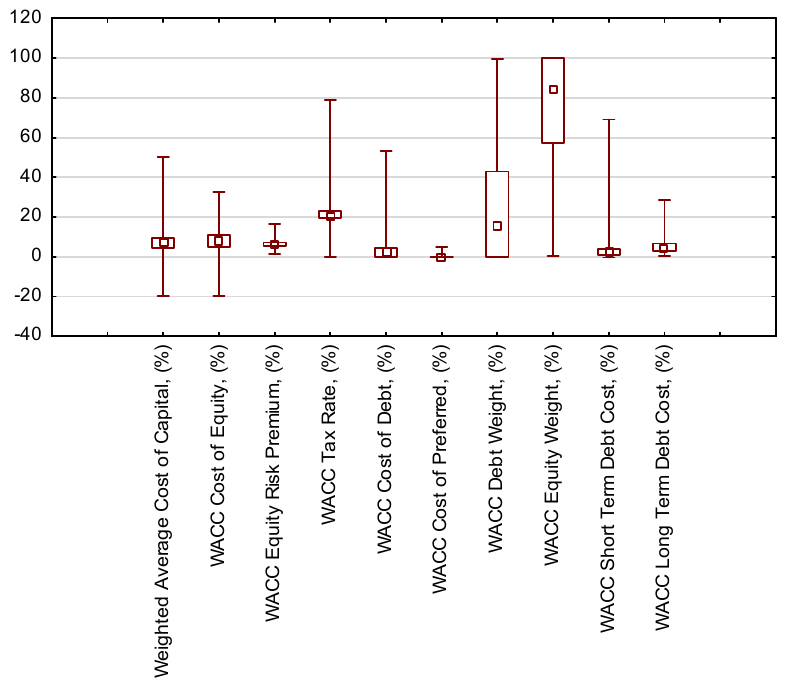
rates and the final results’ WACC calculation.